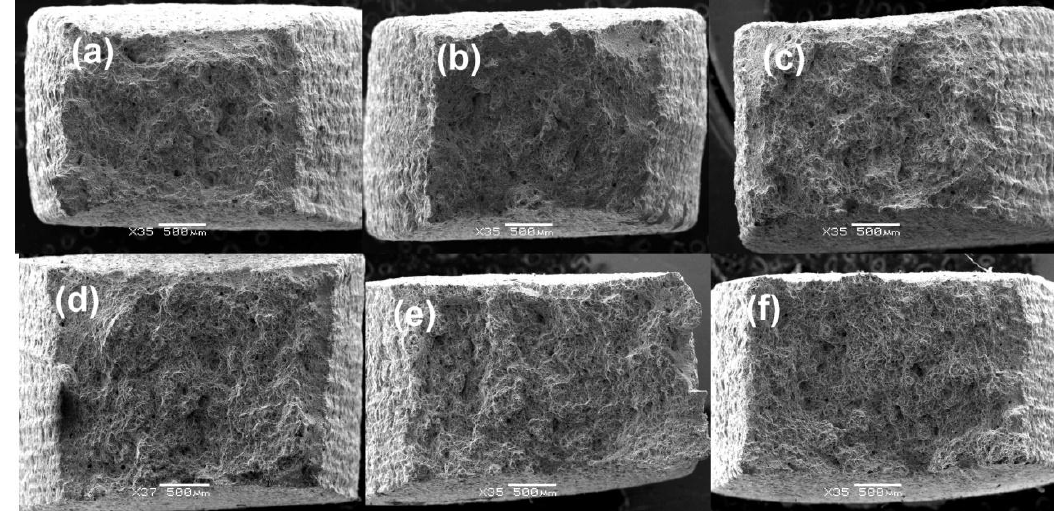
Figure 17. Macro view of fractured surfaces of prestrained CP-Ti: ( a ) 1% prestrained; ( b ) 3.5% prestrained; ( c ) 6.5% prestrained; ( d ) 1% prestrained with annealing; ( e ) 3.5% prestrained with annealing; ( f ) 6.5% prestrained with annealing.